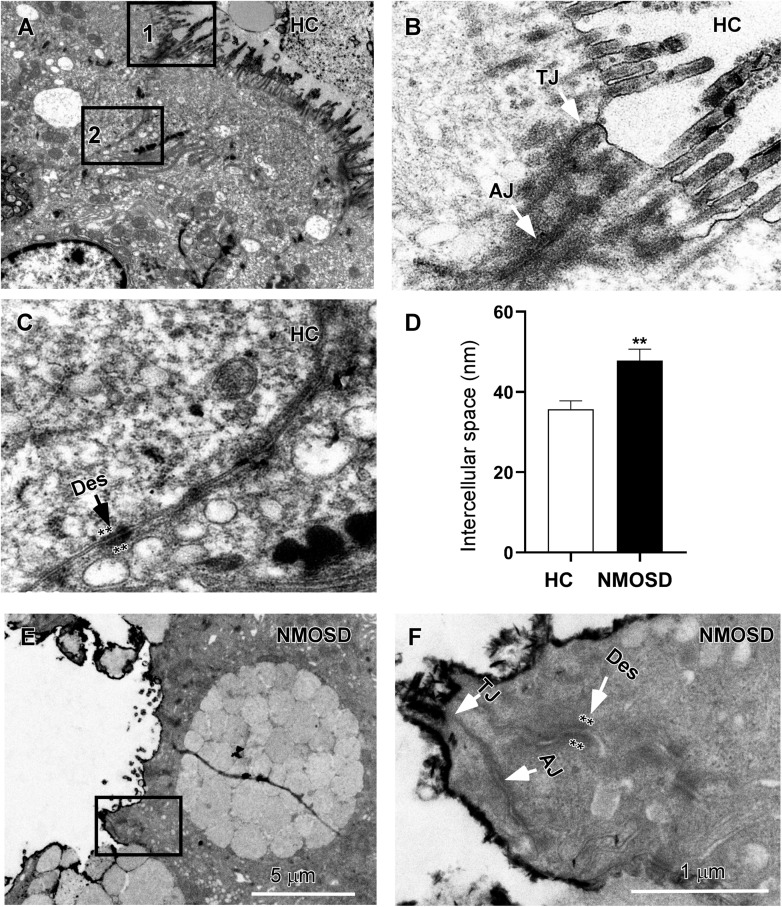
TEM photos and a histogram showing changes in intercellular spaces of the epithelium. (A) Low-power photos showing the intercellular space of the epithelium in HC group. (B) High-power photos showing the tight junction (TJ) from square box 1 of panel (A) and the adherens junction (AJ) from square box 2 of panel (B). (C) High-power photos showing the desmosome (des) with dense and coarse cytoplasmic fibrils attaching on either side of the junction (asterisks). (E) Low-power photos showing the intercellular space of the epithelium in NMOSD patients. (F) High-power photos showing three types of intercellular junctions in NMOSD patients from the square box of panel (E). The dense cytoplasmic materials attaching to either side of junctions were faded (asterisks). (D) Quantitative data show that the intercellular space of these junctions was wider in NMOSD patients than in the HC group (D, **p < 0.01). The scale bar (5 μm) in (E) is equal to that in (A), and the scale bar (1 μm) in (F) is equal that in (B,C).